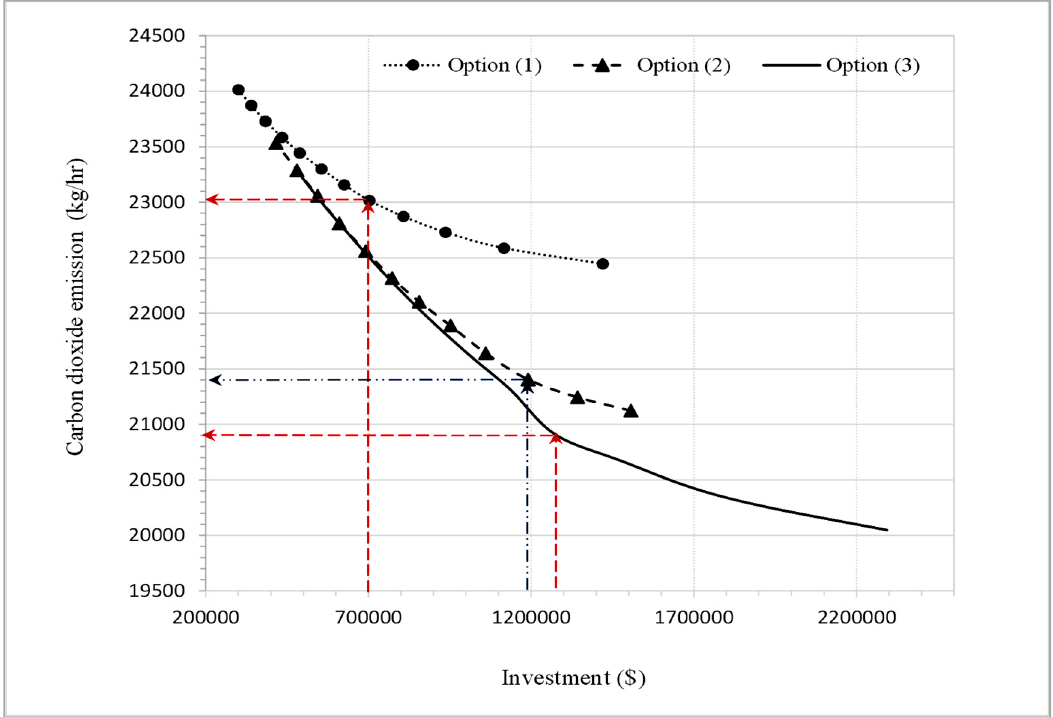
Figure 10. Emission of CO 2 concerning investment for the three options.